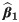
Comparison of average ratios between robust estimates of variance (VR/VT, dashed lines) or naive estimates of variance over true variance (VN/VT, dotted lines) of coefficient
β^1
when P = 10 for different number of clusters (K), as a function of temporal autocorrelation (ρ) and inter-individual heterogeneity (σH2
on the right side of the panels), as well as different data processing: a) Balanced, each cluster has the same number of strata (S = N/K); b) Weakly Unbalanced, K/3 clusters have S/2 strata and 2K/3 clusters have S strata; c) Strongly Unbalanced, K/3 clusters have S/4 strata, K/3 clusters have S/2 strata and K/3 clusters have S strata; d) Destructive sampling, each initial cluster of S strata has been split into 2 clusters, a variable number of strata had been dropped in between to meet the assumption of independence between clusters. Robust or naive estimates of variance are unbiased when ratios are not significantly different from 1 at the 5% level (solid line).